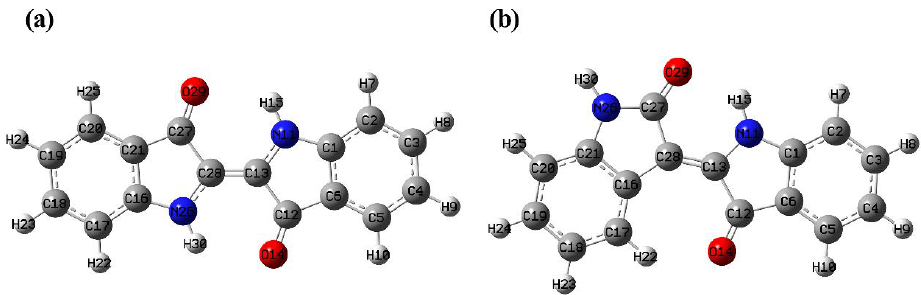
Figure 2. Optimized molecular structures of indigo ( a ) and indirubin ( b ) at B3LYP / 6-311G(d,p). Table 1. Optimized structural parameters for indigo and indirubin at B3LYP / 6-311G(d,p). Structural Parameters Indigo Structural Parameters Indirubin Internuclear Distance (Å) Calc. Exp. [5] Internuclear Distance (Å) Calc. Exp.